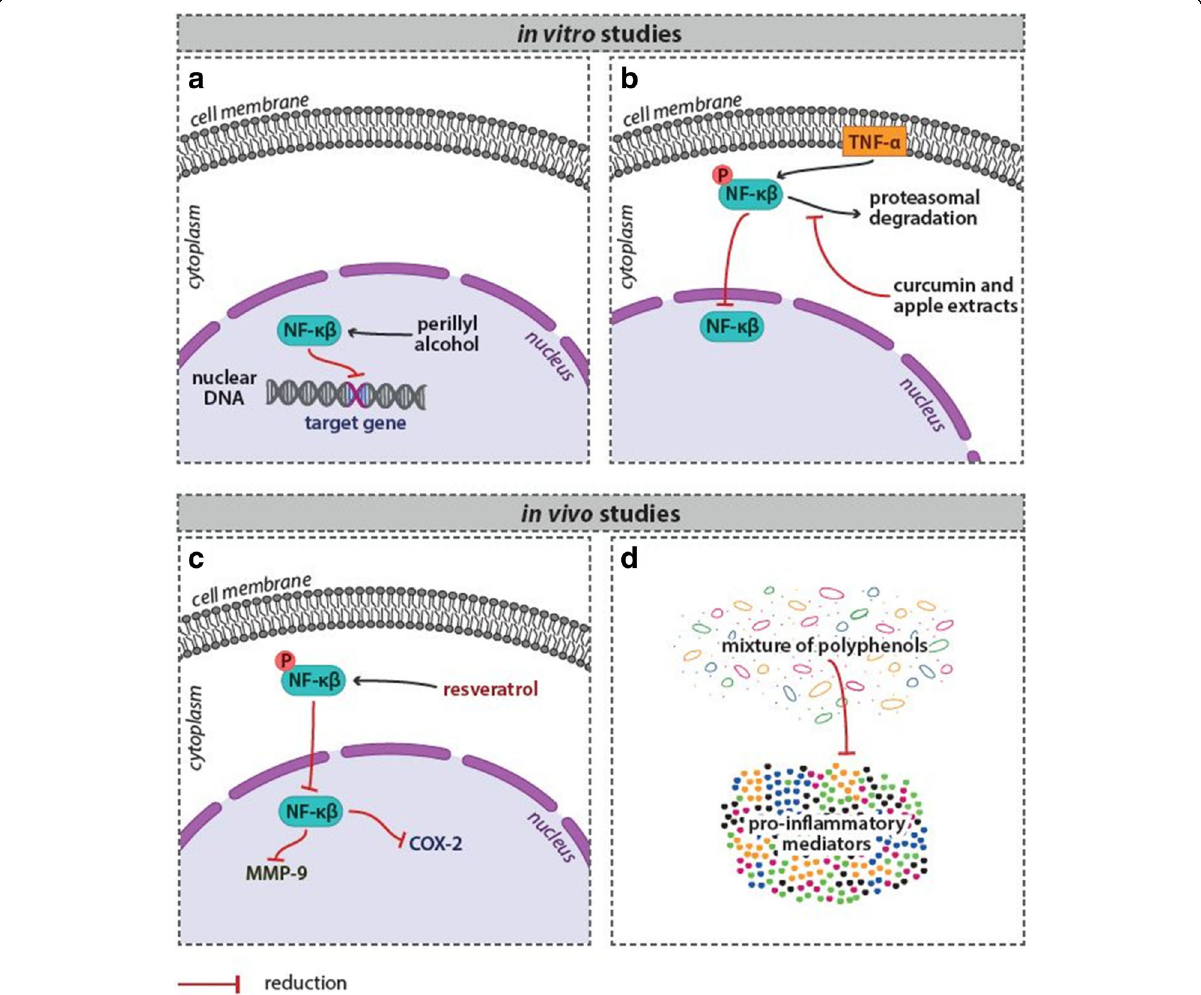
Fig. 2 Phytochemicals reduce inflammation in breast cancer –– evidence of experimental studies. For more details see the text –– the section “ Impact on inflammation